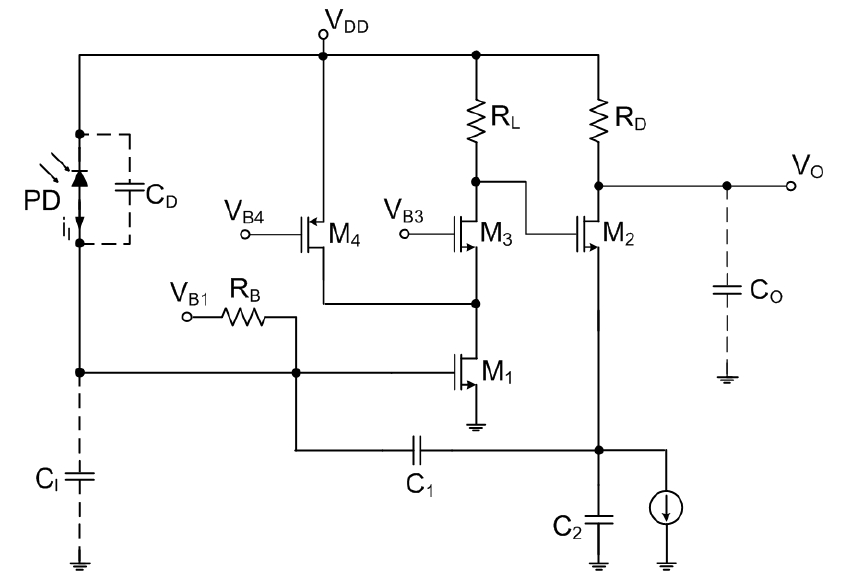
Figure 9. Capacitive-feedback TIA with current steering topology.